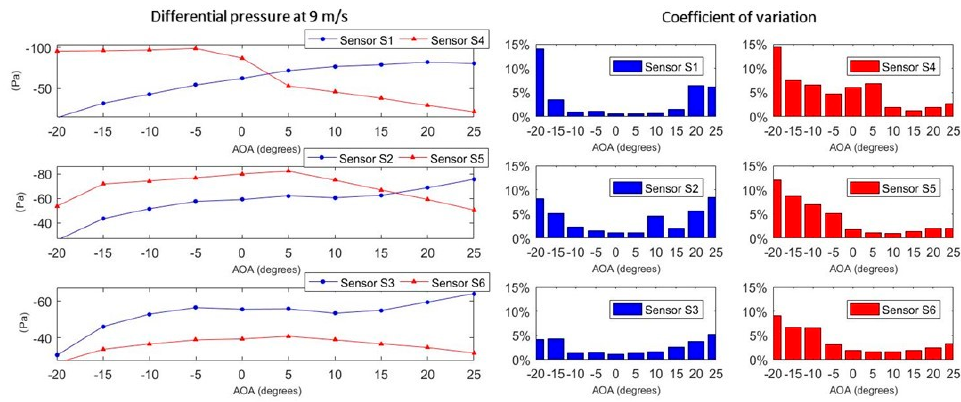
Figure 3. Differential pressures and coefficient of variation against AOA for an air speed of 9 m/s. Figure 3 present the data obtained at 9 m/s grouped by airfoil regions. As can be seen, differential pressures varied from less than − 10 Pa to about − 100 Pa. The upper ‐ front (S1) and the bottom ‐ front (S4) sensors present a wider range, as expected, since lift is concentrated at the initial portion of the airfoil. For the same reason, the upper ‐ rear (S3) and the bottom ‐ rear (S6) sensors present a more stable pattern. The upper ‐ middle (S2) and bottom ‐ middle (S5) sensors present the intermediate conditions linking the leading and trailing edges, which reveals a distinctive behavior at the bottom surface,